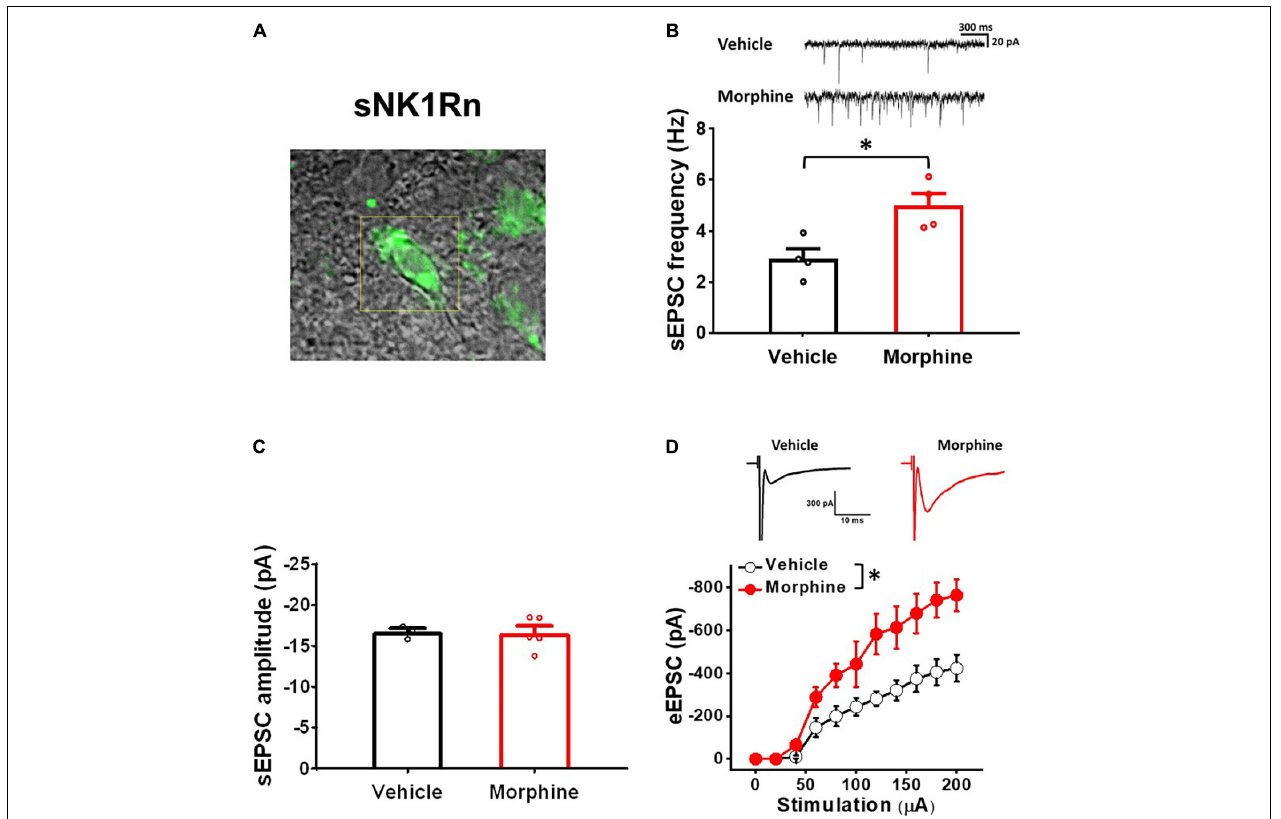
FIGURE 3 | Repeated morphine treatment increased excitatory synaptic strength in sNK1Rn. (A) Fluorescent identification of sNK1Rn. (B) (top) Representative traces of sEPSC and (bottom) sEPSC frequency (effect size: 2.38, p = 0.016; Vehicle: N = 4, n = 27; Morphine: N = 4, n = 35). ∗ p < 0.05 by Welch’s t test (C) sEPSC amplitude (effect size: 0.09, p = 0.891; Vehicle: N = 3, n = 24; Morphine: N = 5, n = 41). (D) (top) Representative traces of eEPSC and (bottom) stimulus-response curve of eEPSC [ F ( 1 , 5 . 56 ) = 9.37, p = 0.024; Vehicle ( N = 4, n = 24), Morphine ( N = 4, n = 26)]. ∗ p < 0.05 vs. vehicle by Sidak’s multiple comparison test following multilevel